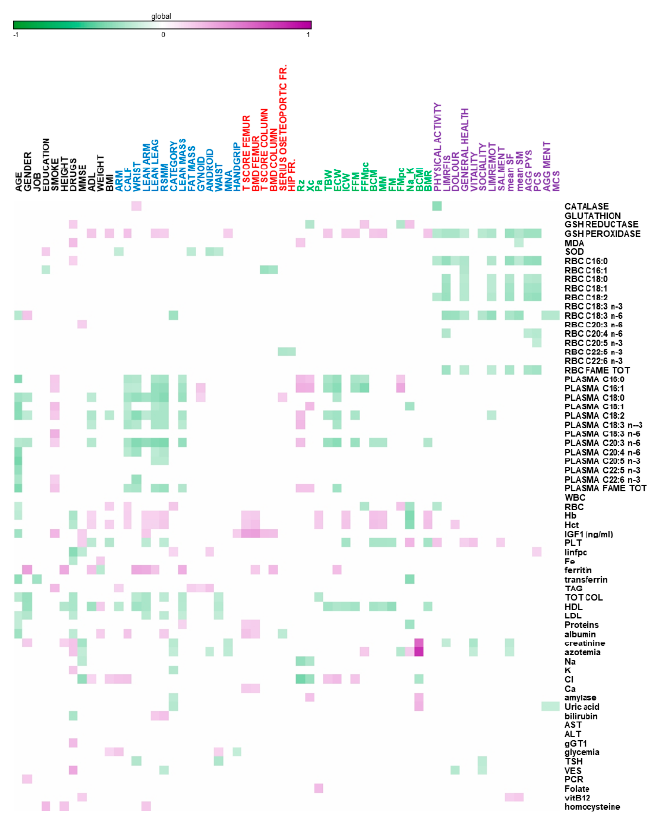
Figure 2. Heatmap reporting Pearson significant correlations ( p < 0.05) among sarcopenic, elderly features versus hematological parameters, antioxidant status, and the lipidomic profile in plasma and red blood cells (RBC).